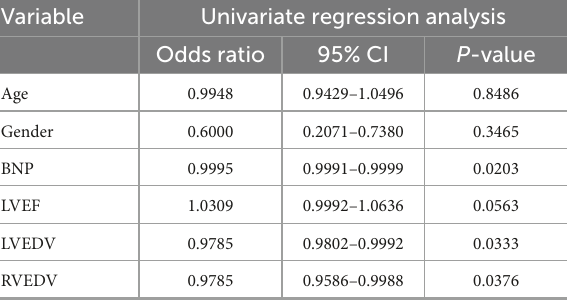
TABLE 3 Univariable analysis of clinical-radiological